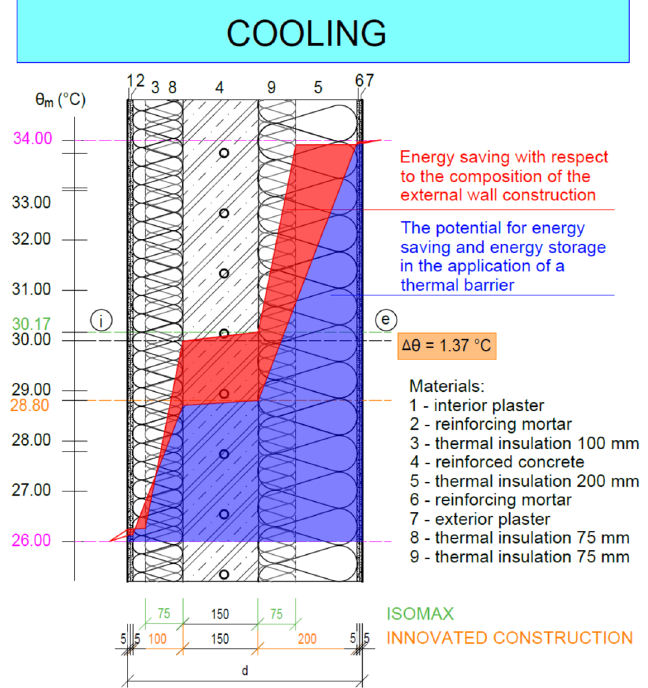
Figure 26. The course of isotherms characterizing the heat transfer through the ISOMAX panel design and the upgraded panel design in the summer period. q i — heat flow towards the interior (W/m 2 ), q e — heat flow towards the exterior (W/m 2 ), θ i = 26 ◦ C—internal calculation tempera-